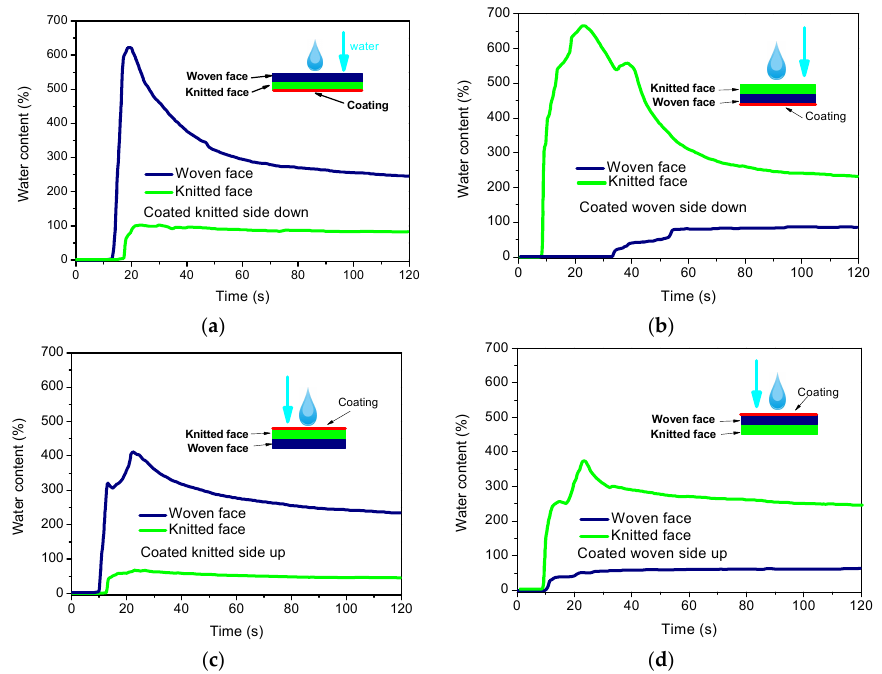
Figure 7. Typical MMT water content curves of bifacial fabrics by dropping water on ( a ) the woven face; ( b ) the knitted face with the coated face down on the MMT; ( c ) the knitted face; ( d ) the woven face with the coated woven face up on the MMT.